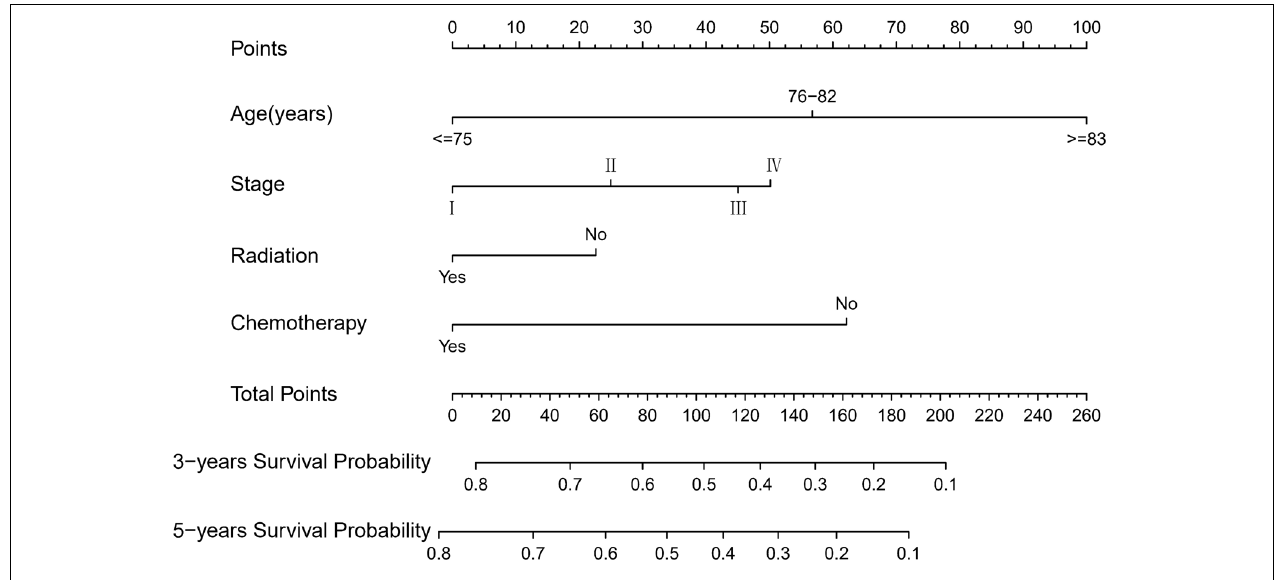
FIGURE 3 | Graphical nomogram scoring system for overall survival.